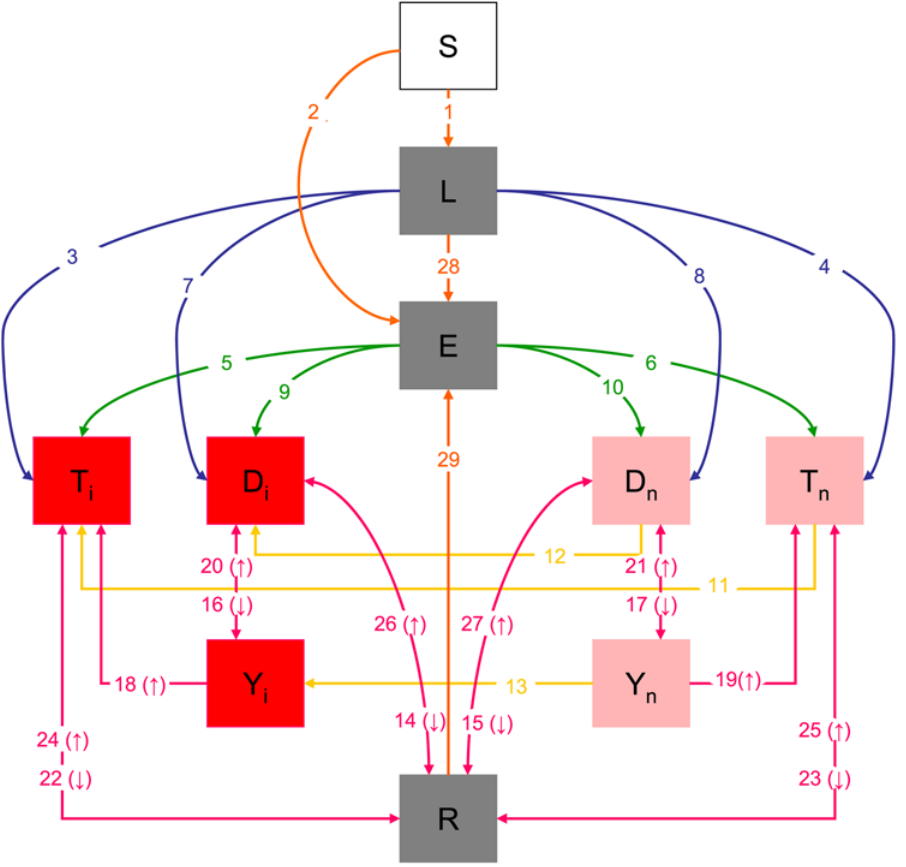
Figure 1. Structure of the mathematical model for the dynamics of tuberculosis in prison. Each box represents a compartment: Susceptible individuals (S), latent fast progressors (E), latent slow progressors (L), cured individuals (R), infectious/non-infectious cases who will be detected and treated (D i /D n ), infectious/non-infectious cases who will not be detected and treated (T i /T n ), infectious/non-infectious treated cases with treatment failure (Y i /Y n ). Red boxes represent a disease-infectious state, pink boxes represent a disease-non infectious state and grey boxes represent infected individuals without disease. Entries and discharges in and out of the prison are not represented on this figure.